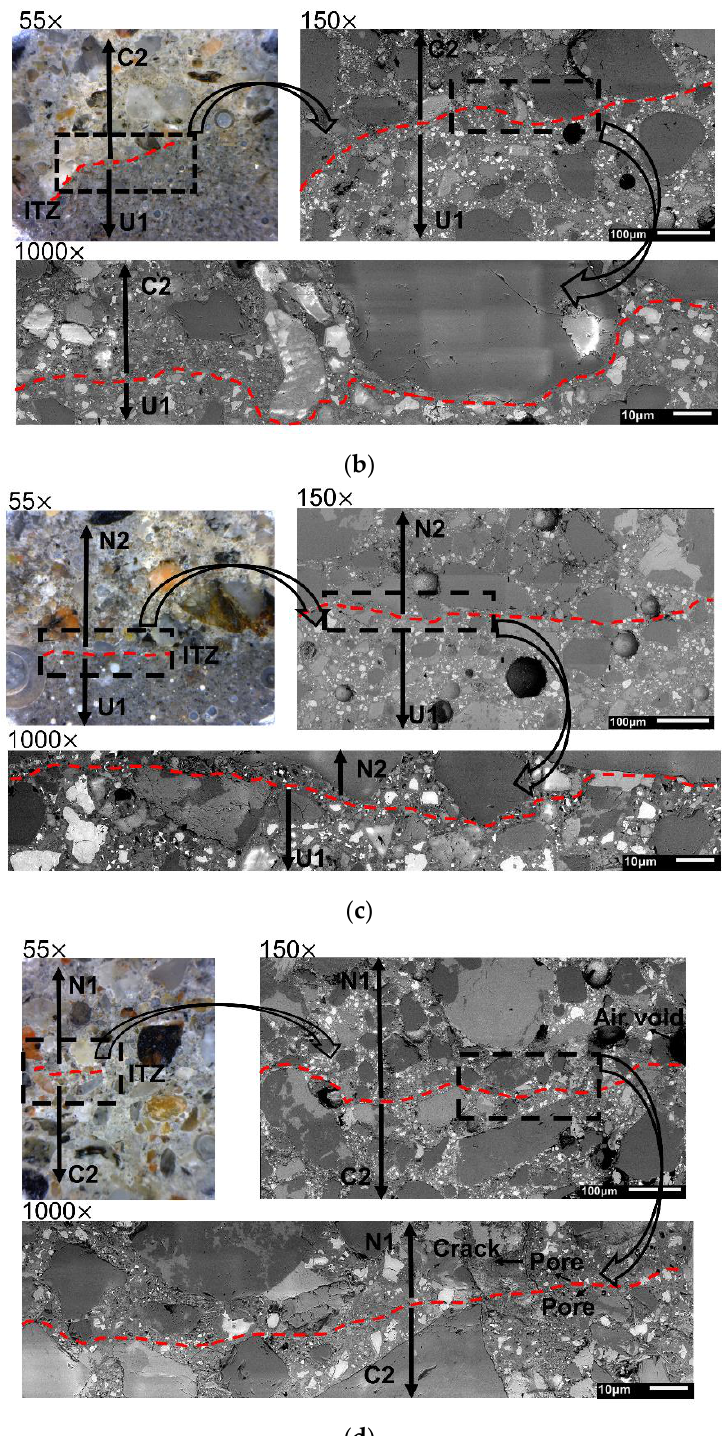
Figure 4 . Transition zone observed in hybrid concrete at 55× magnification (digital light microscope) Figure 4. Transition zone observed in hybrid concrete at 55 × magnification (digital light microscope) and at 150× and 1000× magnification (SEM): ( a ) U1N1, ( b ) U1C2, ( c ) U1N2, ( d ) N1C2 . and at 150 × and 1000 × magnification (SEM): ( a ) U1N1, ( b ) U1C2, ( c ) U1N2, ( d )